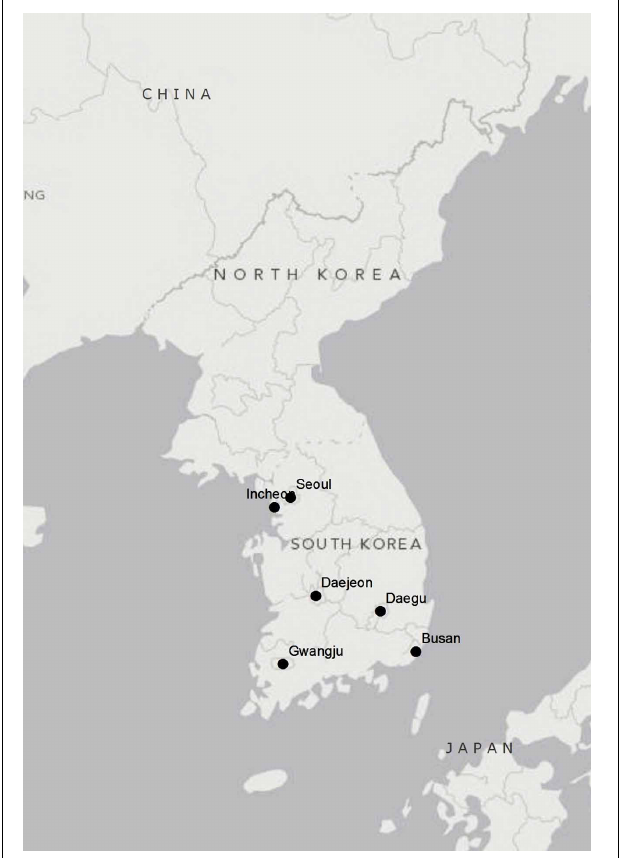
FIGURE 1 | Location of six major cities in South Korea included in this